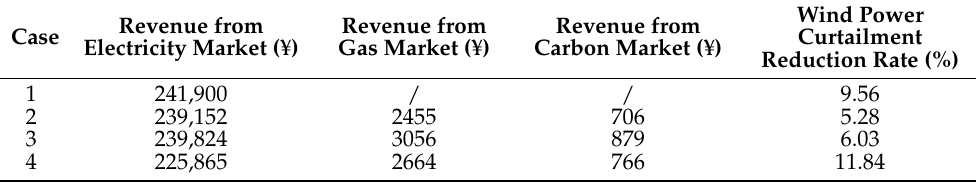
Table 3. Revenues from multiple energy markets and effect on wind power curtailment reduction rate.